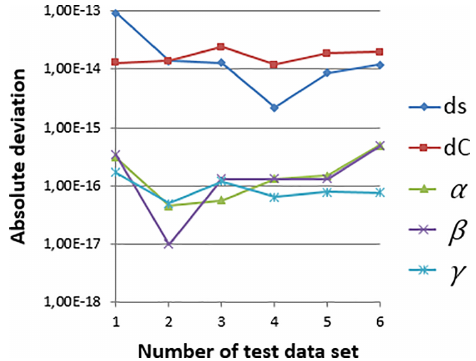
Figure 6. Deviation of the calculated flange fit to the reference so-